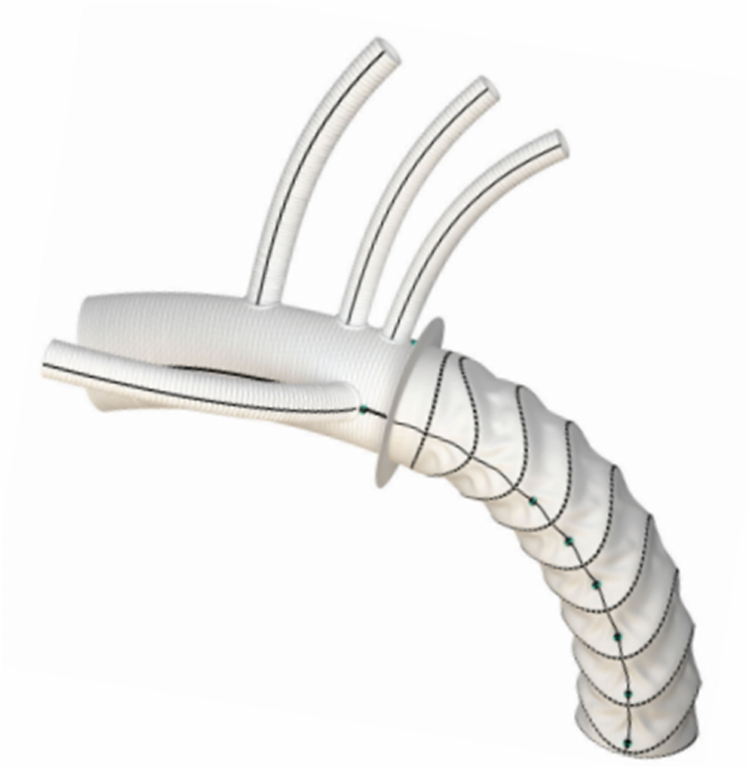
Figure 6. Vascutek Thoraflex hybrid device is composed of a proximal four-branched pre coated woven polyester prosthesis sealed to a distal covered stent graft. The stented portion of the graft is a self-expanding endoprosthesis made with polyester and nitinol ring stents, which are attached to a fabric with braided polyester